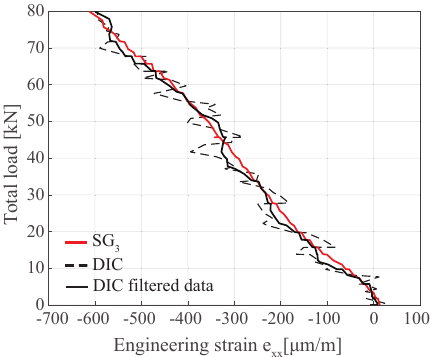
Figure 6. Comparison between strain gauge SG 3 e xx data with the DIC strain measurements at the same point. Applying a smoothing function for removing DIC noise, a good agreement is found between the two, with DIC strain noise levels being within the typical prescribed resolution of ± 100